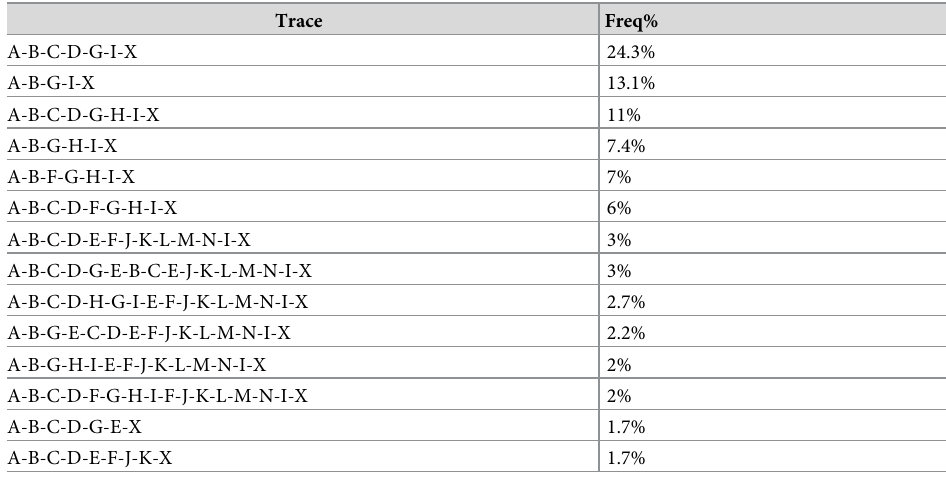
Table 5. Most frequent traces.